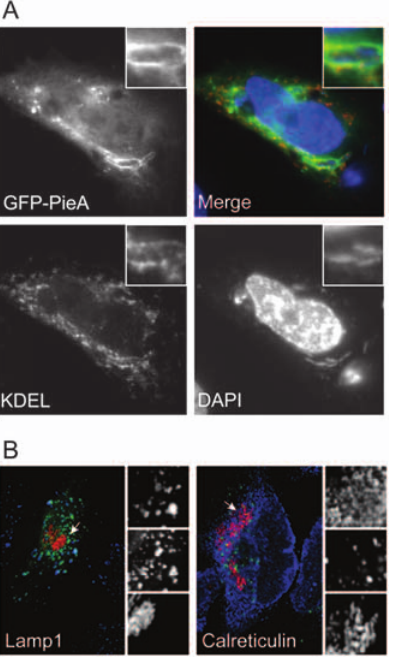
Figure 4. GFP-PieA and KDEL co-localize on the membrane of vacuoles containing L.pneumophila , but not on those contain- ing the ER-resident bacterium B. abortus . (A) CHO Fc c RII cells transiently expressing the fusion protein GFP-PieA were Infected with wild-type L. pneumophila for seven hours and stained for the ER marker KDEL to identify the membrane of vacuoles containing L. pneumophila . Vacuoles containing bacteria are magnified in the inset of each image. GFP-PieA is found decorating the L. pneumophila containing vacuole where it co-localizes with the ER marker KDEL. (B) HeLa cells were transfected to express GFP-PieA and infected with B. abortus strain DsRedm-2308 for 24 hours before processing for confocal microscopy analysis. Bacteria (appear red) do not recruit GFP-PieA (appears green) to their replicative vacuoles. GFP-PieA remains associated with LAMP1- positive vesicles (appear blue, left panel) and does not co-localize with the ER marker calreticulin (appears blue, right panel) around the B. abortus –containing